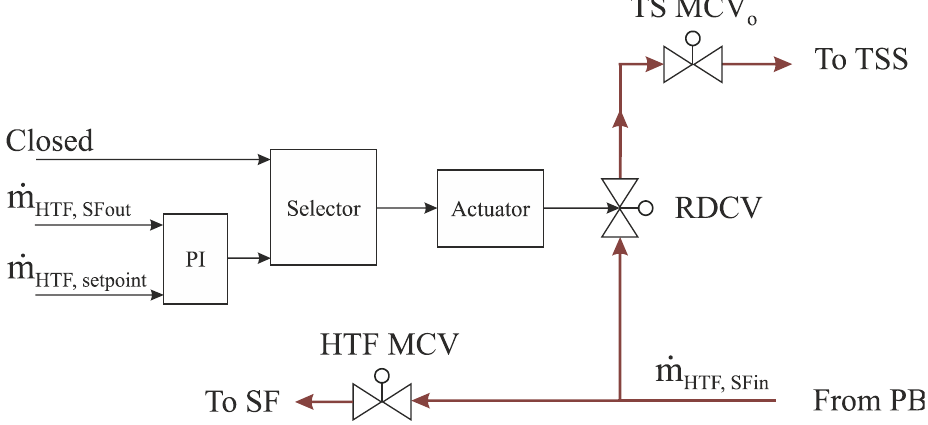
Figure 6. HTF control valve between the SF outlet and the TS inlet (simplified).